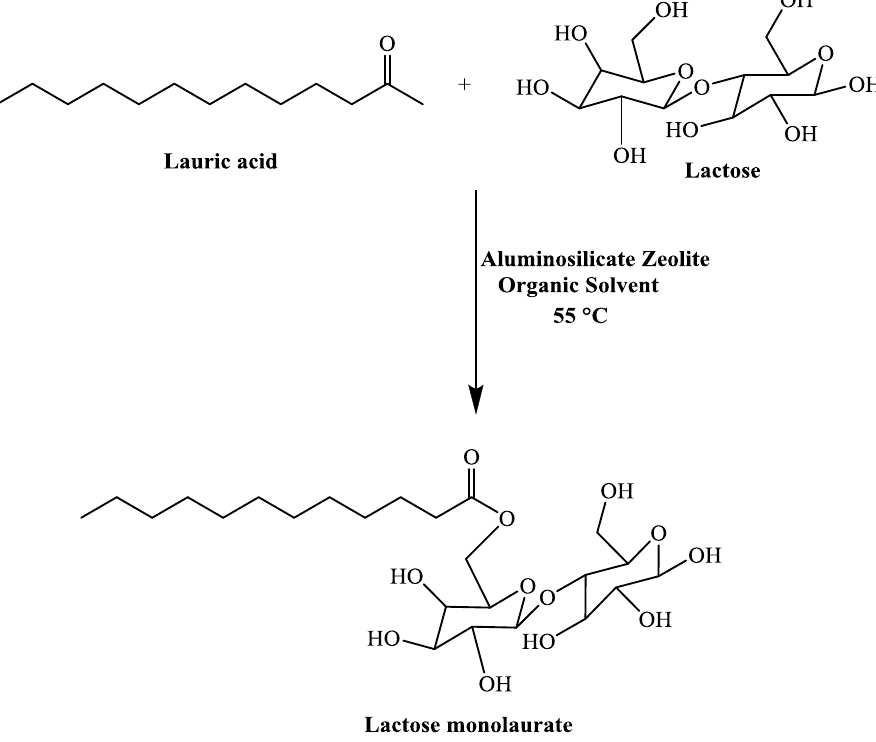
Figure 12. Esterification of lauric acid with lactose over aluminosilicate zeolite [130] .